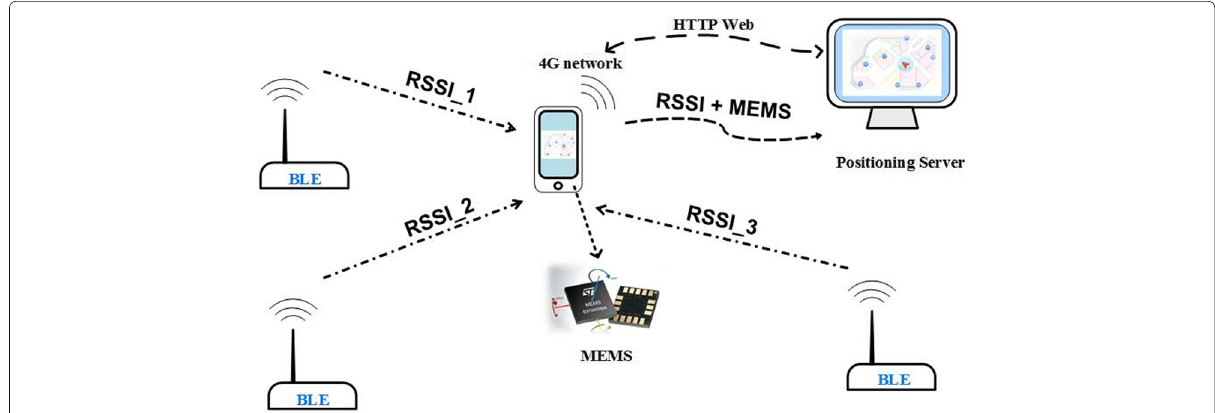
Fig. 10 Schematic diagram of the proposed system